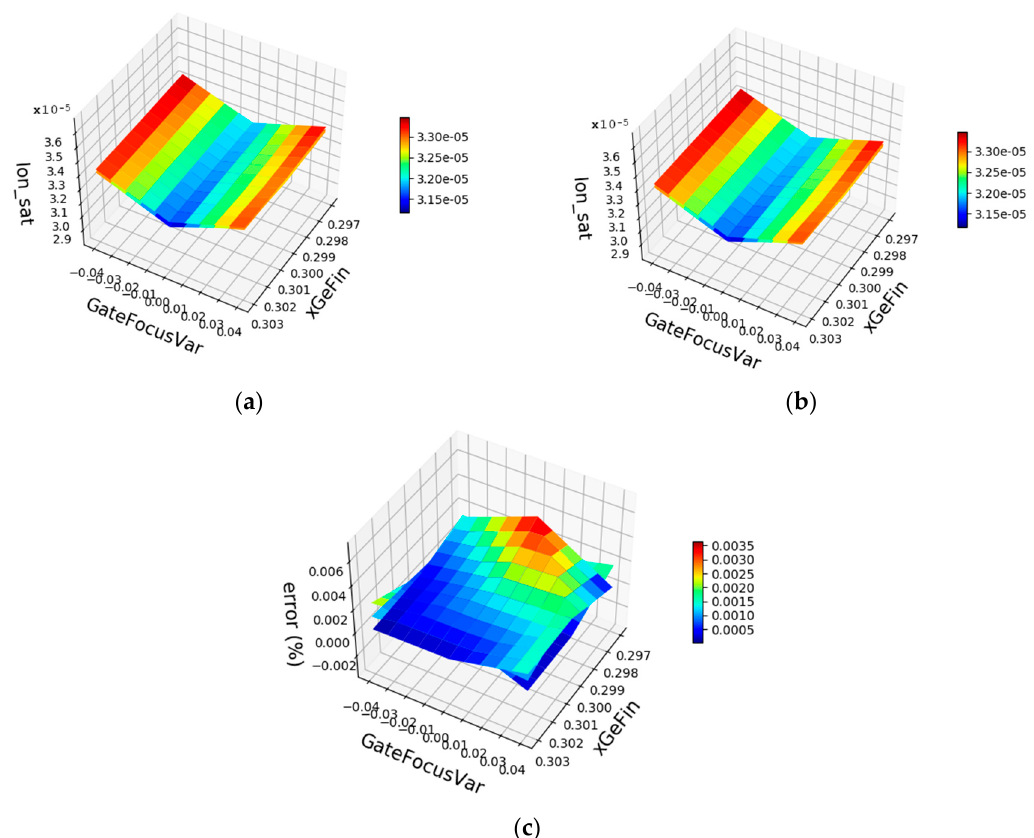
Figure 16. Example for extraction of extended compact model: Comparison between results ( a ) from TCAD; ( b ) from the extended compact model for the saturation current (color scale in Ampere of a nanowire NMOS; ( c ) relative error (color scale in %) of the compact model compared with TCAD.